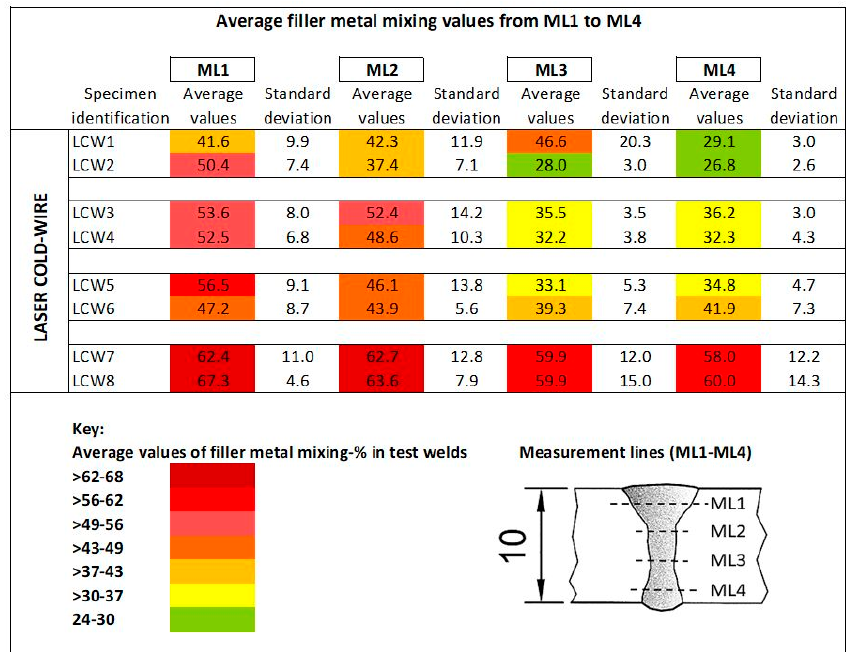
Figure 16. Tabular data presenting average values of filler metal mixing-% from the data of measurement lines ML1–ML4 in laser cold-wire test welds.